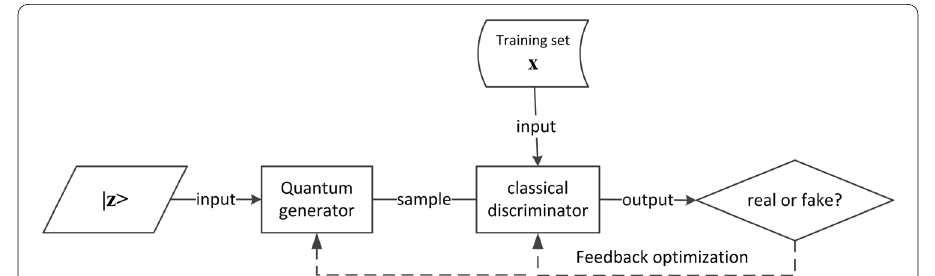
Fig. 3 Schematic diagram of quantum generative adversarial network